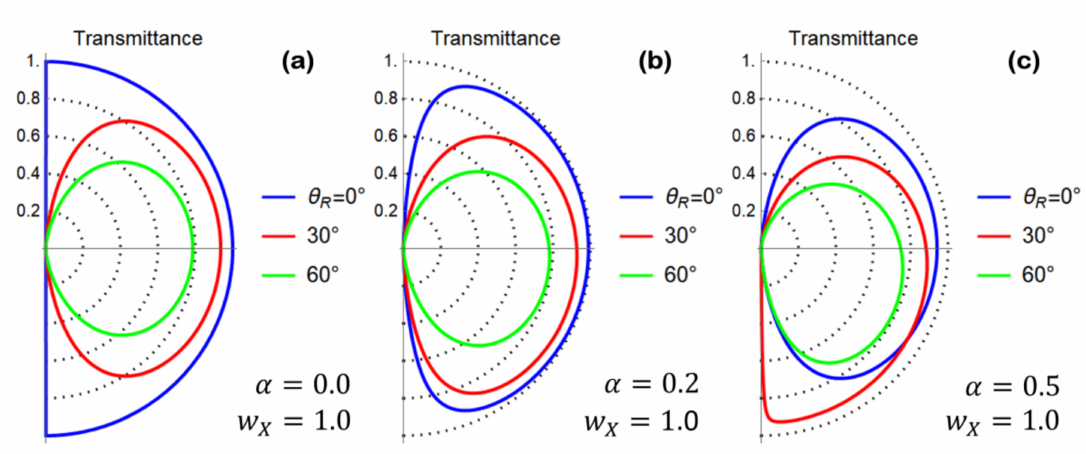
Figure 4. ( a ) Polar plot of the transmittance computed according to Equation (45) by setting the model parameters as shown in the figure legend. Preferential transport directions are absent, while the transmission probability is reduced as the misorientation angle θ R is increased. ( b ) Polar plot of the transmittance computed according to Equation (45) by setting α = 0.2 and w X = 1. Preferential transport directions are observed. ( c ) Polar plot of the transmittance computed according to Equation (45) by setting α = 0.5 and w X = 1. Preferential transport directions are